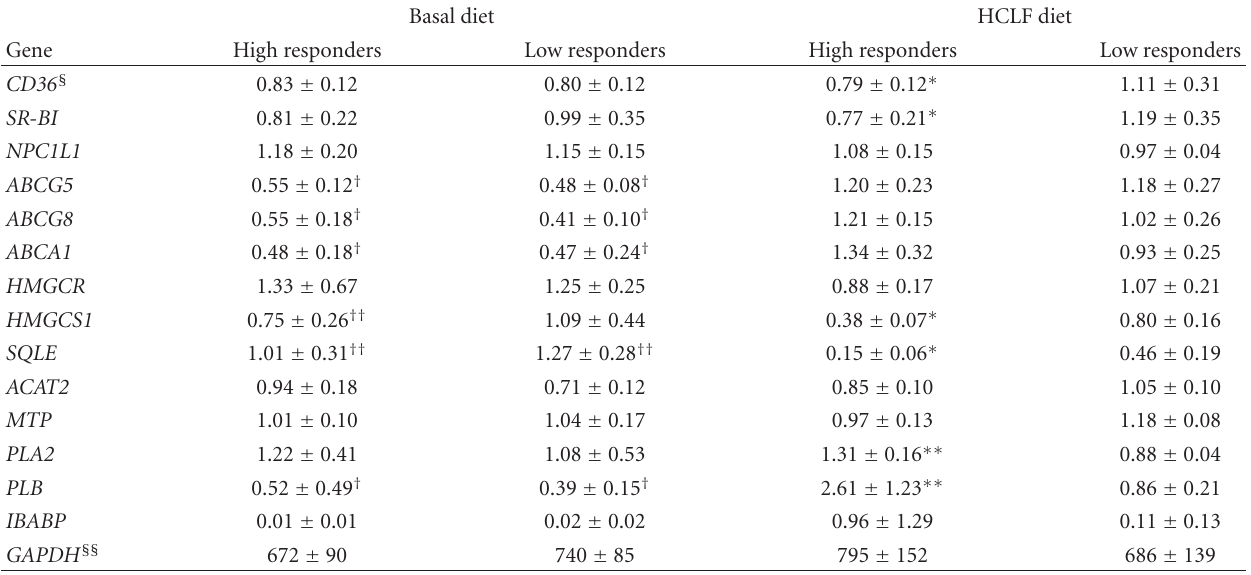
Table 2: Expression of intestinal genes in high and low responders fed the basal or HCLF